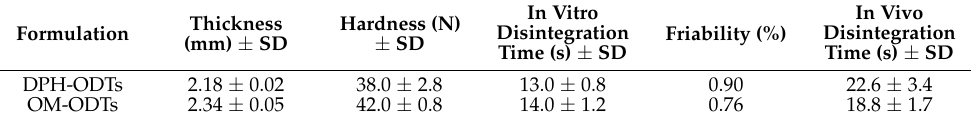
Table 8. Physical properties of